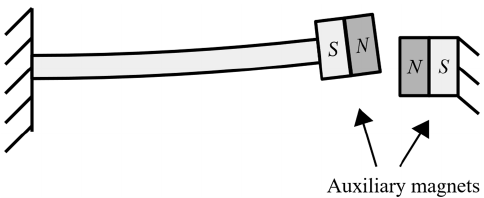
Figure 7. Topology of auxiliary magnets for nonlinear vibration PEH systems.